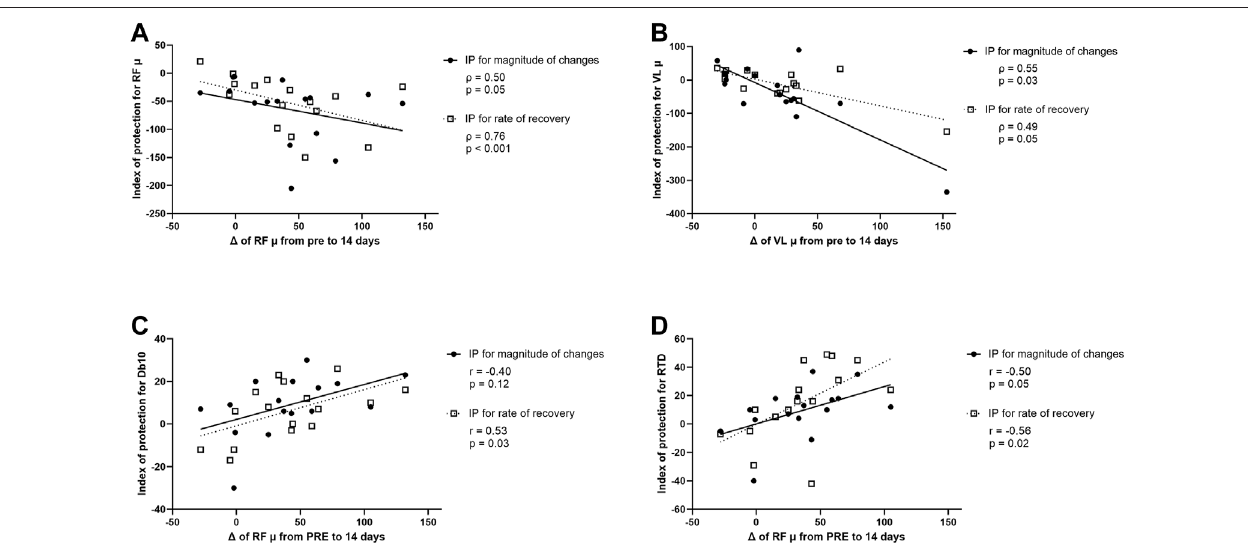
FIGURE 7 | (A) Correlation between modi fi cations ( Δ ) of rectus femoris (RF) muscle shear elastic modulus (µ) from PRE to 14 days after the fi rst exercise (i.e., from PREexercise1toPREexercise2)andindexofprotection(IP)formagnitudeofchanges( fi lledcircle)orrateofrecovery(opensquare)forRFµ. (B) Correlationbetween Δ of vastuslateralis (VL)µfromPREto14 daysafterthe fi rstexerciseandIPformagnitudeofchanges( fi lledcircle)orrateofrecovery(opensquare)forVLµ. (C) Correlation between Δ ofRFµfromPREto14 daysafterthe fi rstexerciseandIPformagnitudeofchanges( fi lledcircle)orrateofrecovery(opensquare)fortheamplitudeofthe doubletat 10 Hz(Db10). (D) Correlationbetween Δ ofRF µfromPREto14 days afterthe fi rstexercise andIPformagnitudeofchanges( fi lledcircle)andrateofrecovery (open square) for the rate of torque development (RTD).